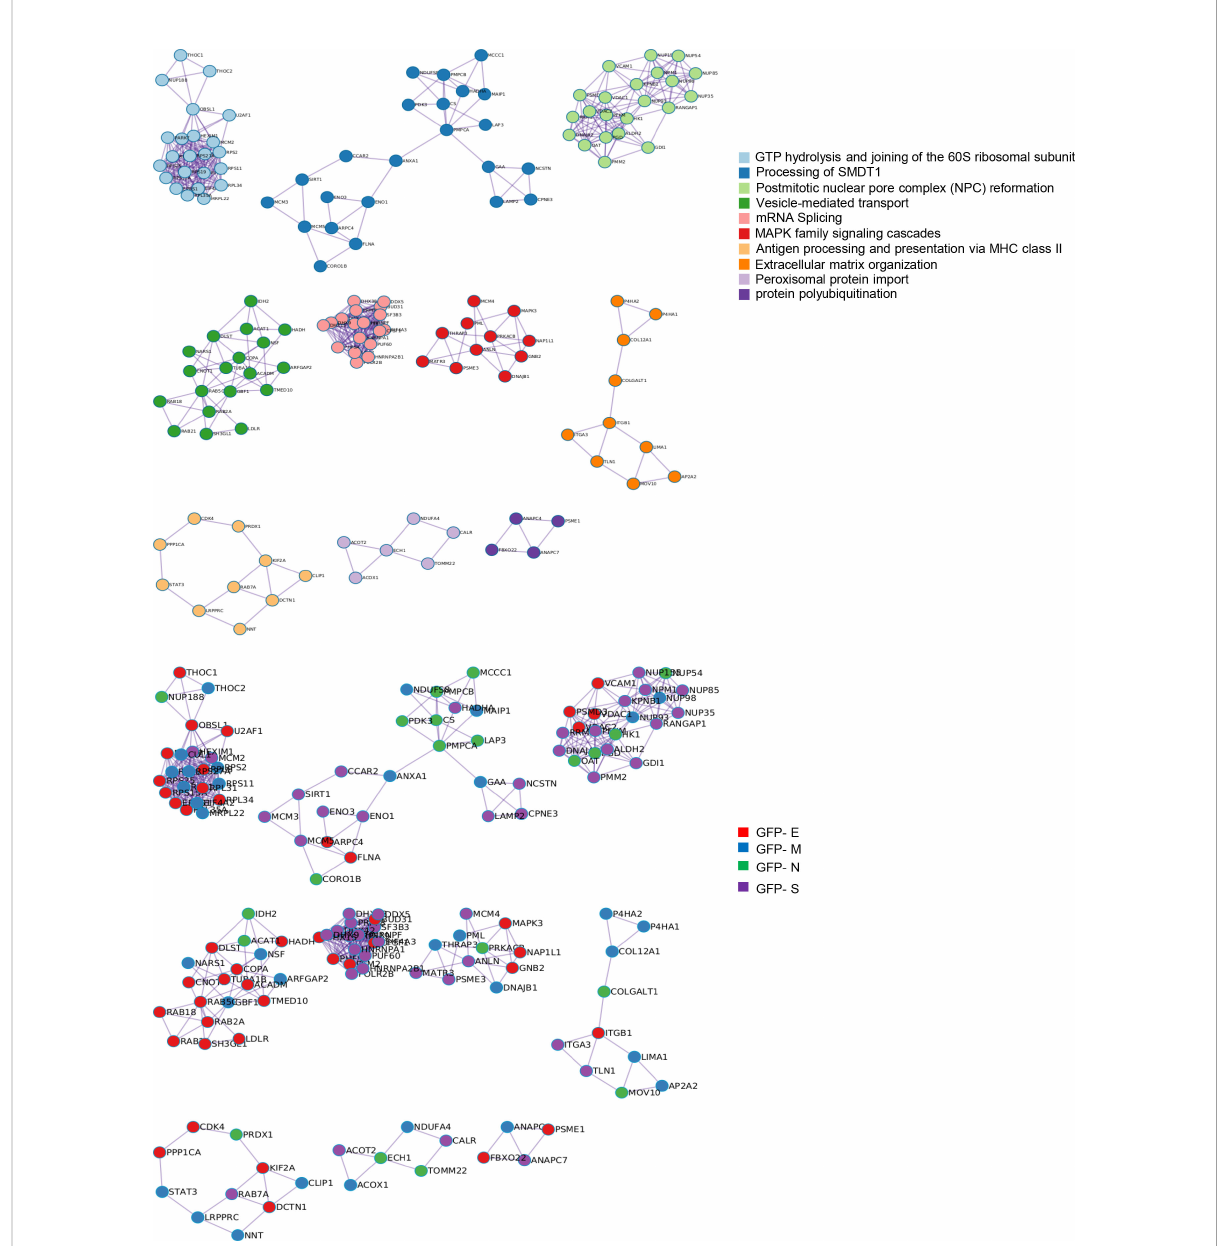
FIGURE 2 Intracellular protein complexes affected by SARS-CoV-2 structural protein expression. MCODE algorithm (61) was applied to automatically extract protein complexes embedded in proteomics datasets. The three most signi fi cantly enriched ontology terms were combined to functionally annotate each MCODE complex (Upper). Each GFP-tagged SARS-CoV-2 protein differentially modulated each MCODE complex in OBC1 cells